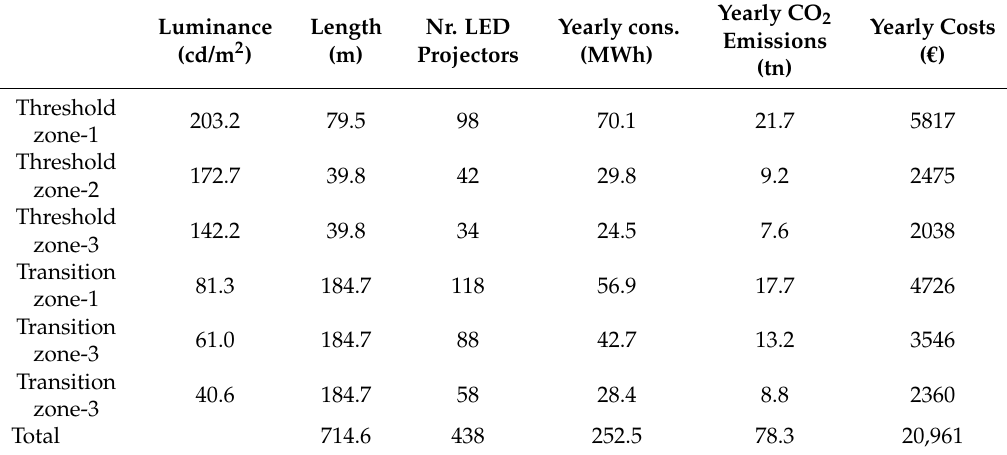
Table 4. Main parameters of lighting installation impact after basic actions for energy savings are implemented. Yearly CO 2 Yearly Costs Luminance Length Nr. LED Yearly cons. Emissions ( € ) (cd/m 2 ) (m) Projectors (MWh) (tn) 203.2 79.5 98 70.1 21.7 5817